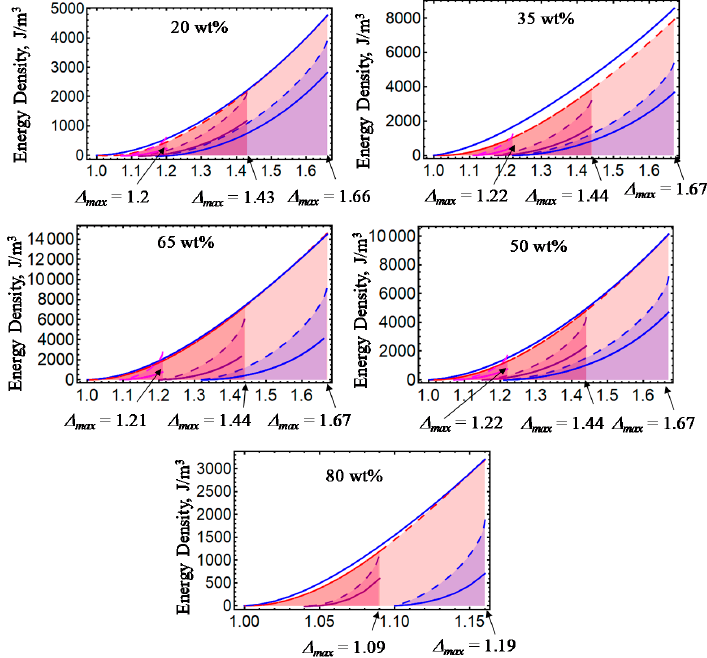
Figure 5. Energy dissipation energy curves for anisotropic magnetorheological material samples subjected to loading and unloading cycles with B = 52.2 mT.